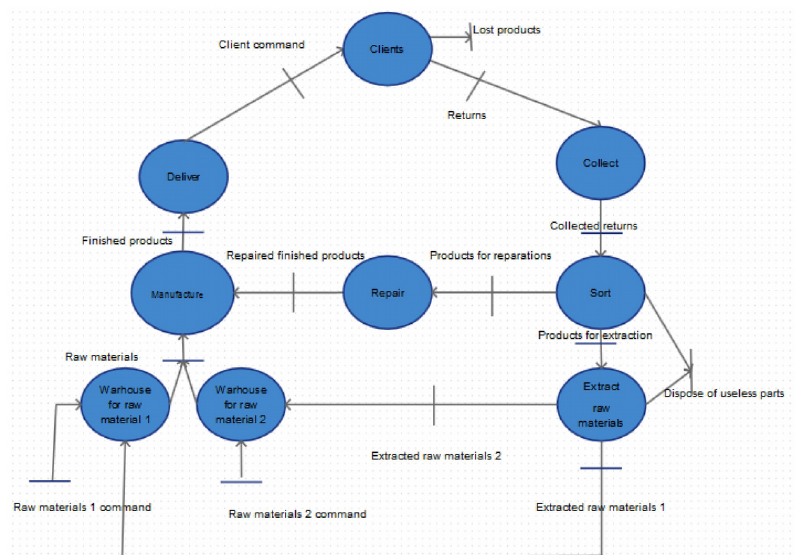
Figure 5. Case study